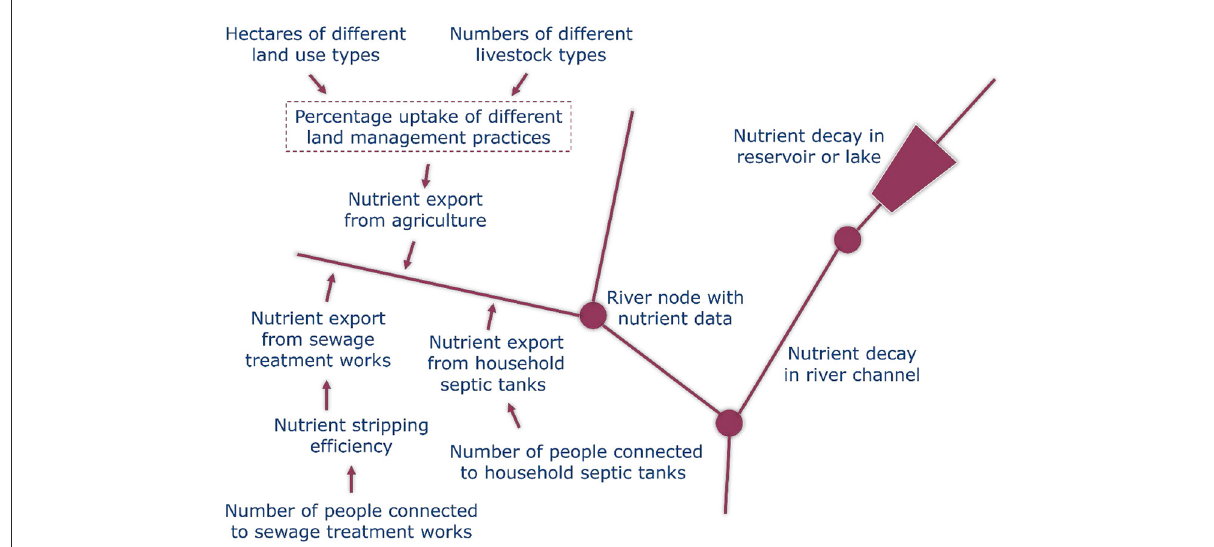
FIGURE3 Description of an export coefficient type nutrient transfer model (own elaboration).